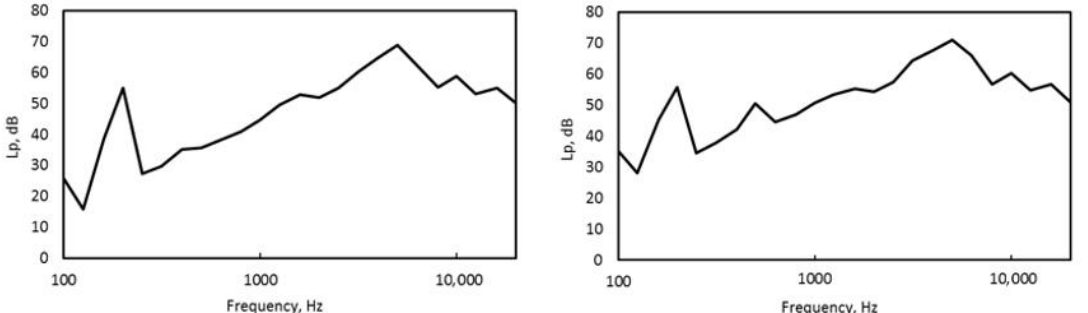
Figure 2 . Values of the minimum (at the left) and average (at the right) spectrum emitted in the anechoic chamber by the operation of a UAV. It is possible to note the presence of the 5000 Hz tonal component.